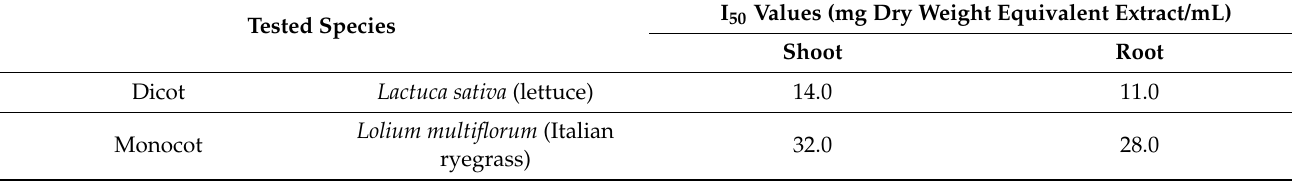
Figure 2. Phytotoxicity of the H 2 O methanolic extracts of Albizia richardiana on the growth of the shoots and roots of the seedlings of Lactuca sativa (lettuce) and Lolium multiflorum (Italian ryegrass) at different concentrations. Mean ± SE (standard error) was calculated from two separate studies (replicated three times; number of seedlings /treatments was 10, and total seedlings n = 60). Different letters indicate significant variations according to homogenous subsets of Tukey’s HSD test at the 0.05 level of significance. Table 1. The I 50 values (concentrations resulting in 50% growth restriction) of the Albizia richardiana H 2 O (aqueous) methanolic extracts against the test plants .